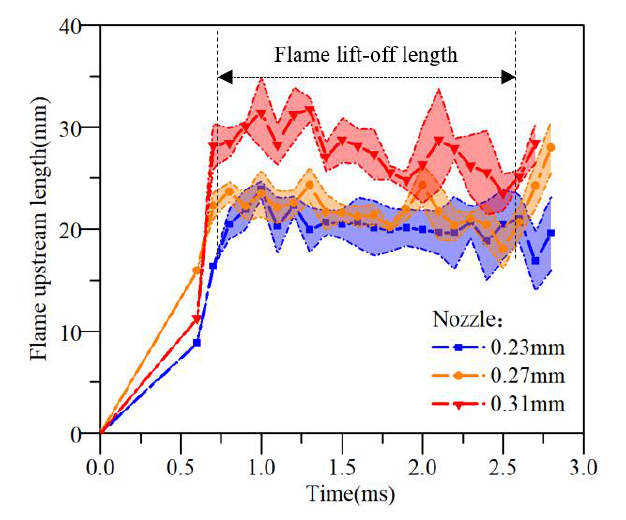
Figure 14. Flame upstream length and flame lift-off length. Table 8. Average flame lift-off length.